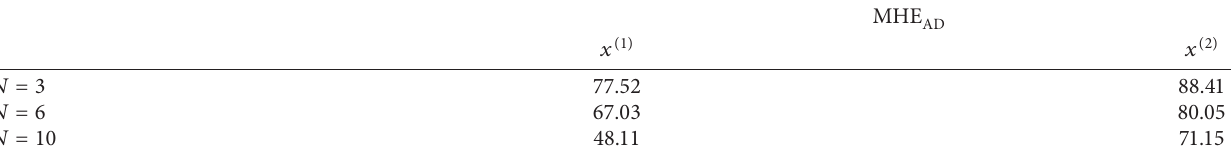
Table 2: Comparison of the effect of the horizon size on the average sum square estimation error for states x ( 1 ) and x ( 2 )